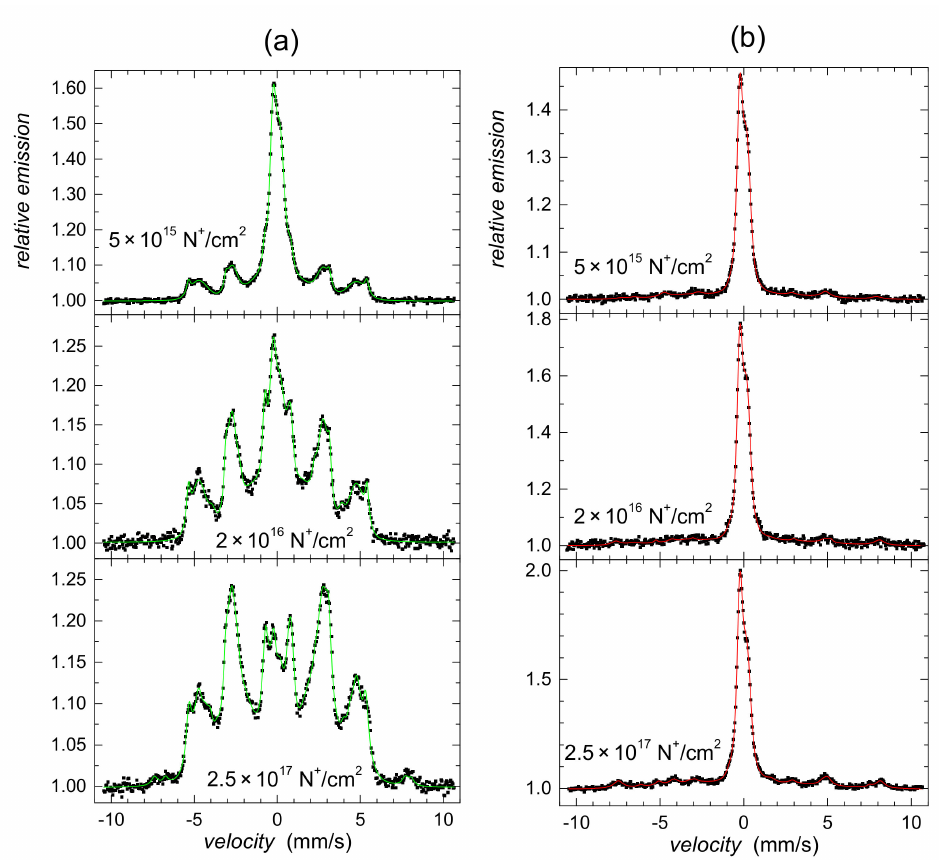
Figure 12. CEMS spectra of 57 Fe 81 Mo 8 Cu 1 B 10 amorphous metallic ribbons recorded from its: ( a ) Air side (green); ( b ) wheel side (red) after irradiation by 130 keV N + ions with the indicated